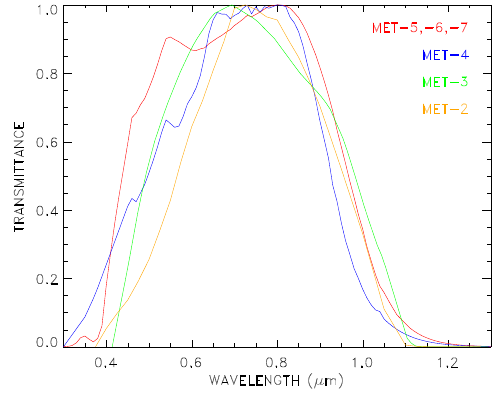
Figure 1. Spectral response functions of the visible channel of Meteosat First Generation